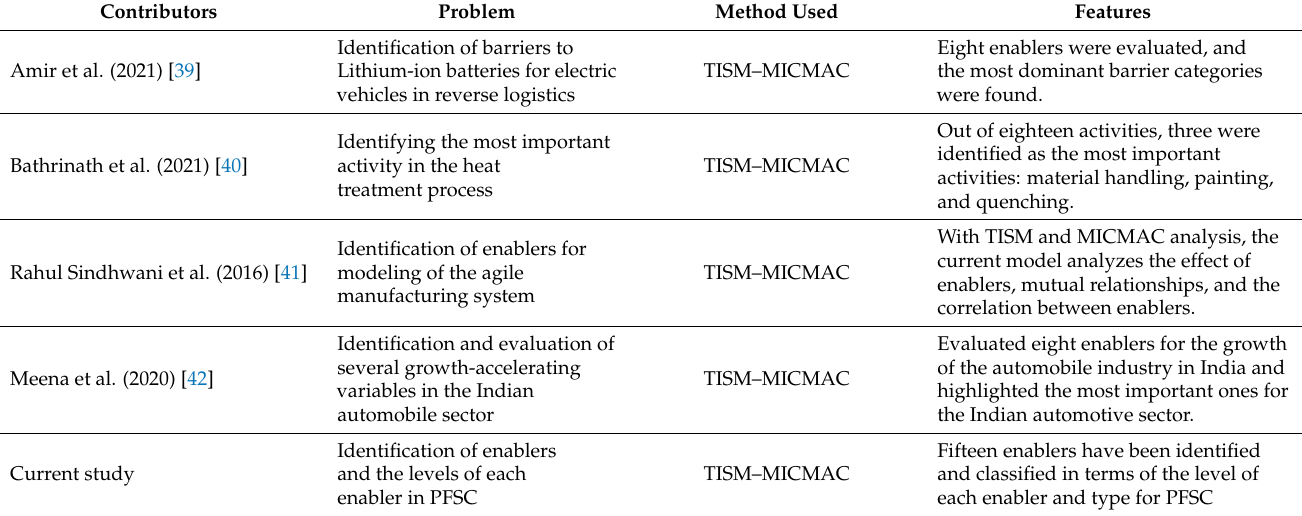
Table 3. Summary of literature review for TISM–MICMAC